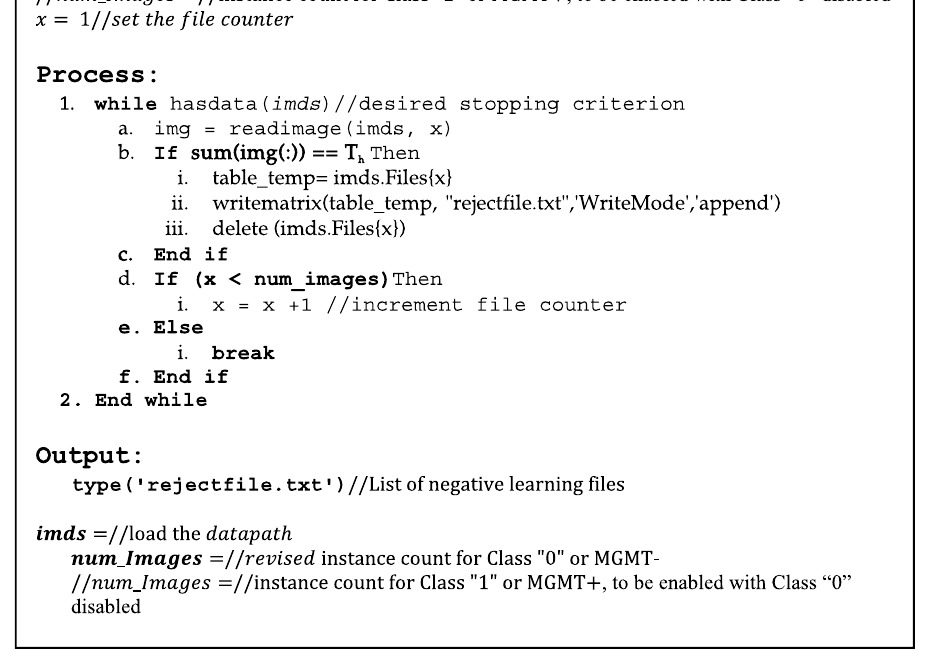
Figure 4. Pseudocode for the file rejection algorithm